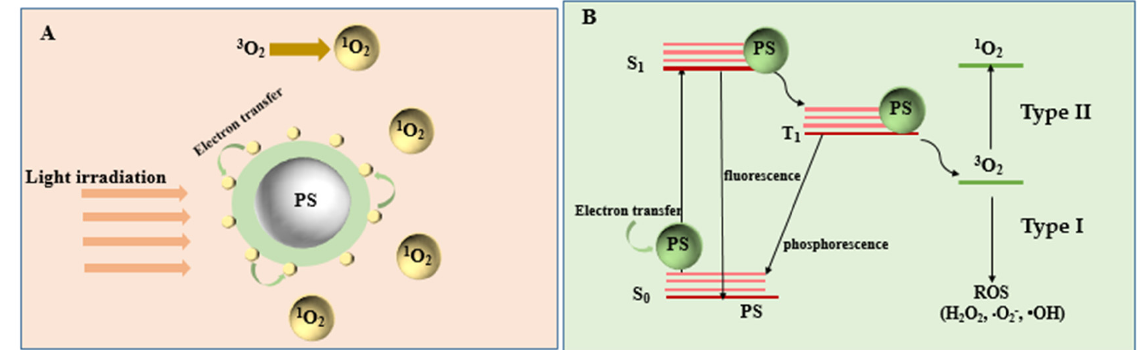
Figure 2. Diagram of the PDT mechanism at the moment when energy is transferred from photosensitizers (PS) to activate the photosensitizers. ( A ) The generation of 1 O 2 through the electron transfer process. ( B ) The process of energy transfer and the PDT mechanism.